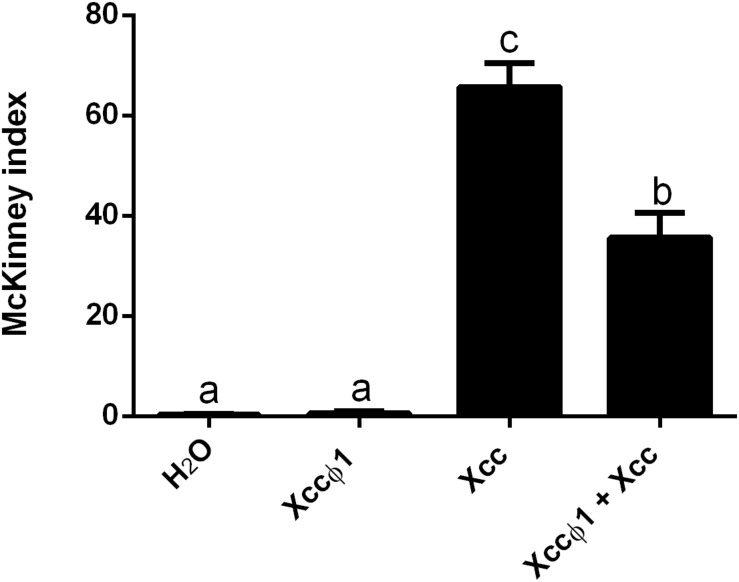
Effect of the Xccφ1 phage treatments on Xcc disease severity, as measured by the McKinney index, with foliar applications to plants of B. oleracea var. gongylodes. Xcc was inoculated at 108 CFU/mL, while Xccφ1 at 109 PFU/mL. In the combined treatment, phage, and bacterium were applied simultaneously. Values are the mean ± SD of three replicates (60 plantlets each) per treatment. Bars labeled with the same letter are not statistically different at the Tukey test (p < 0.05).